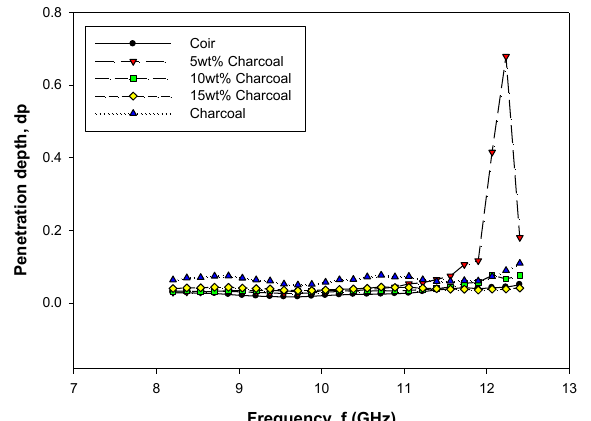
Figure 8: Penetration depth over the x-band frequency range Using equation (3) to (6), the attenuation constant (α) and phase constant ( β ) of the samples are calculated.